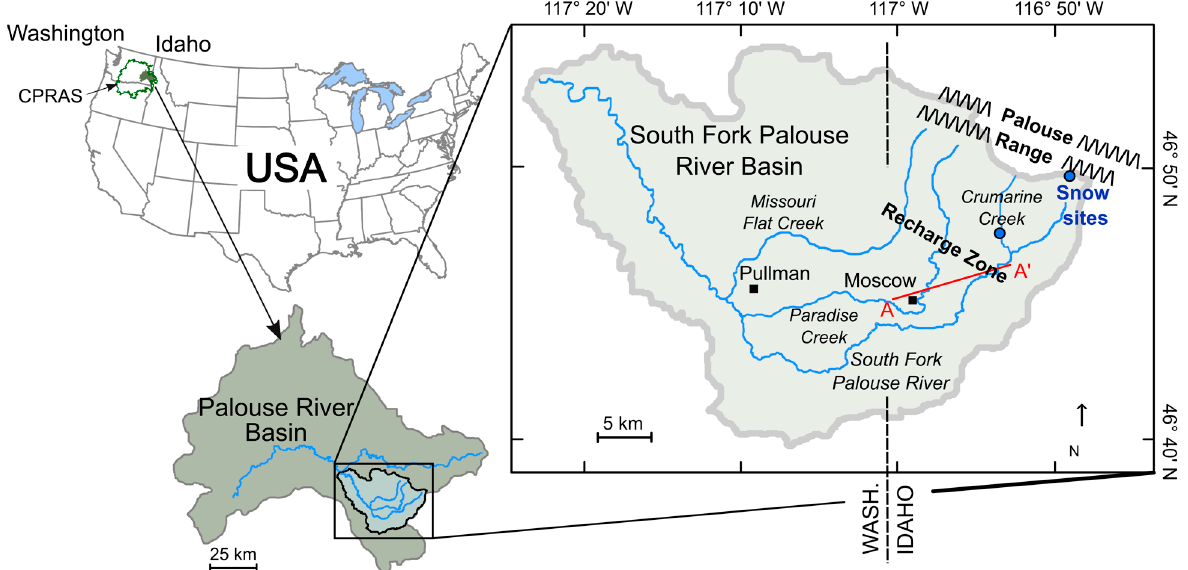
Figure 1. South Fork Palouse River Basin in the Palouse River Basin of the Columbia Plateau Regional Aquifer System (CPRAS), USA (modified from Duckett et al. [15]). Transect A–A’ pertains to the cross section shown in Figure 2.